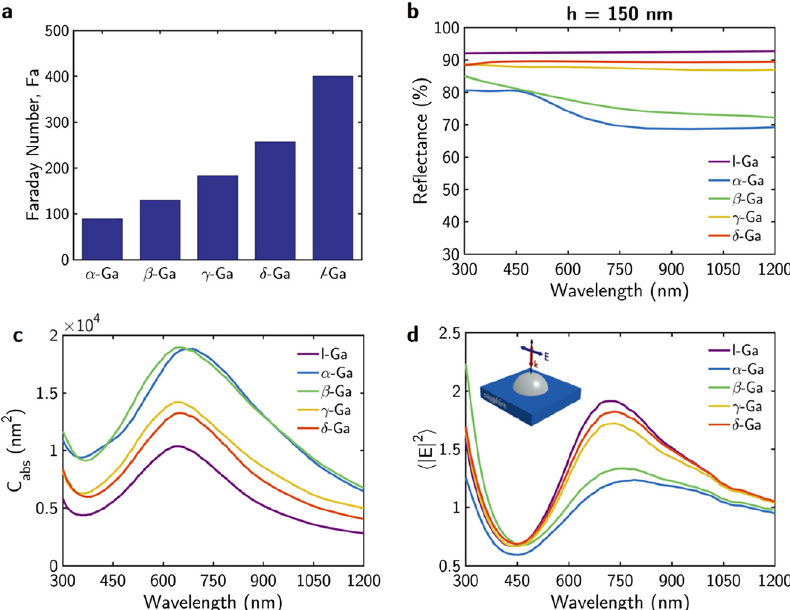
Figure 4: Evaluation of plasmonic performance of thin films